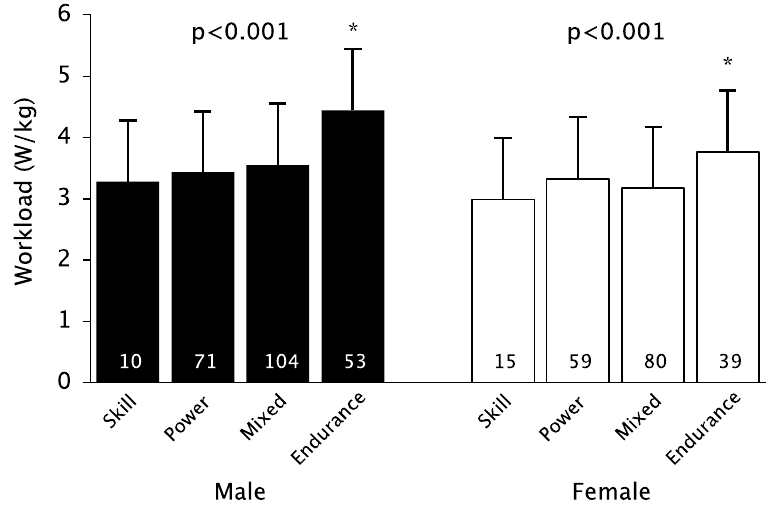
Figure 1. Sport types comparison of workload. * p < 0.05 post hoc tests Endurance vs. all other types.